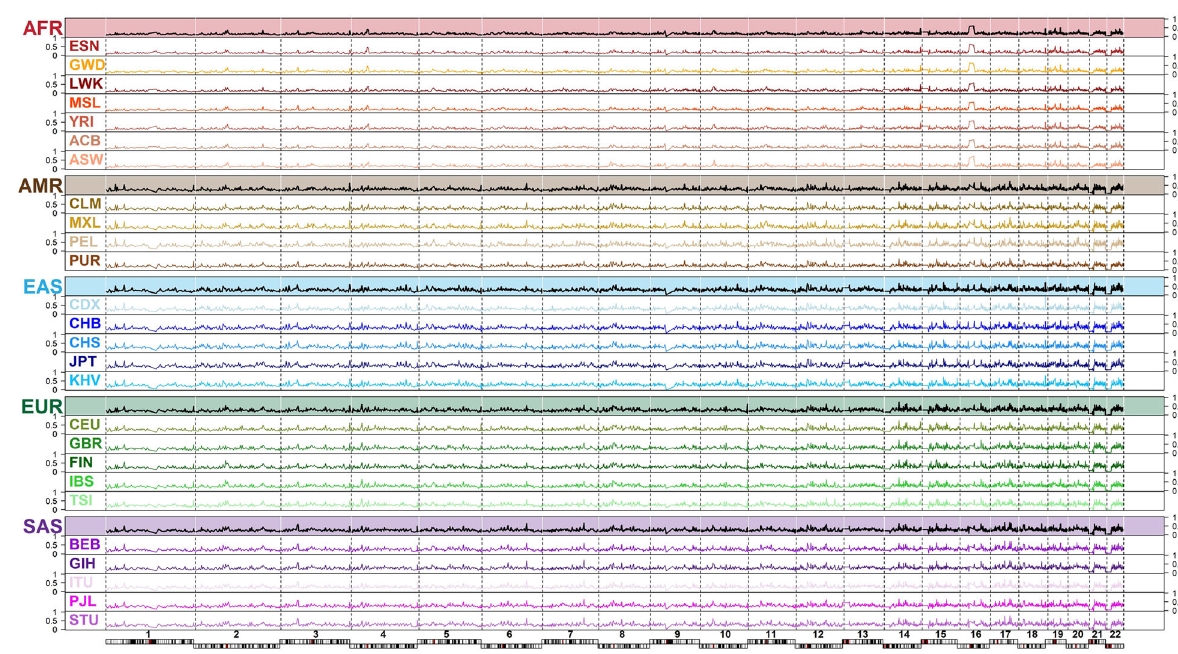
Fig. 5 Genomic pro fi les of homozygosity intensity in global continents and populations. Sample size n = 2504